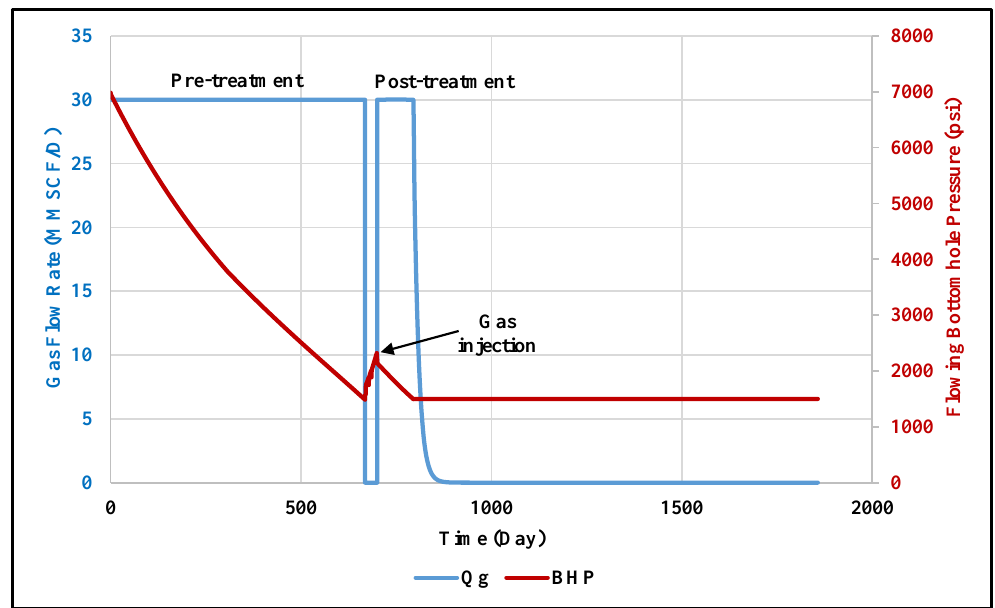
Figure 20. Profiles of gas production and associated flowing bottom-hole pressure before and after gas-injection treatment.